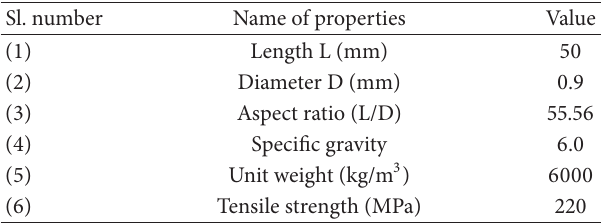
Table 3: Properties of steel fiber used in the present study. Sl.